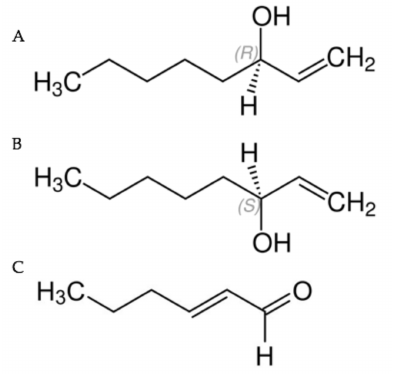
Figure 1. ( A ) ( R )-( − )-1-octen-3-ol ( R form); ( B ) ( S )-(+)-1-octen-3-ol ( S form); ( C ) trans